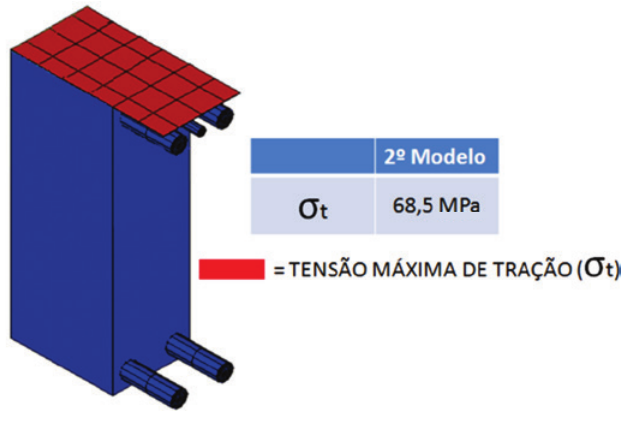
Figura 17 Tensões no PRFC na seção de momento